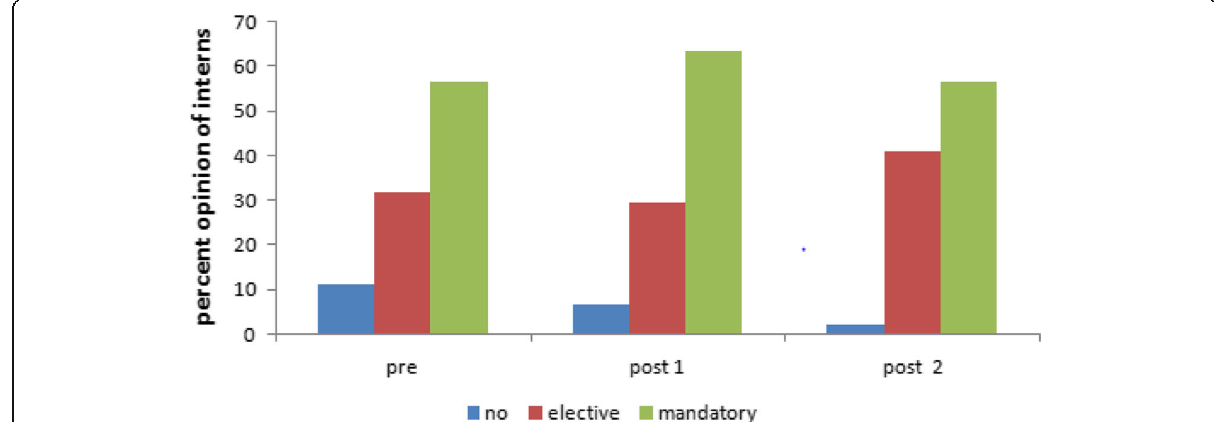
Fig. 3 Percent opinion about having educational breastfeeding course during the internship year before and after the education